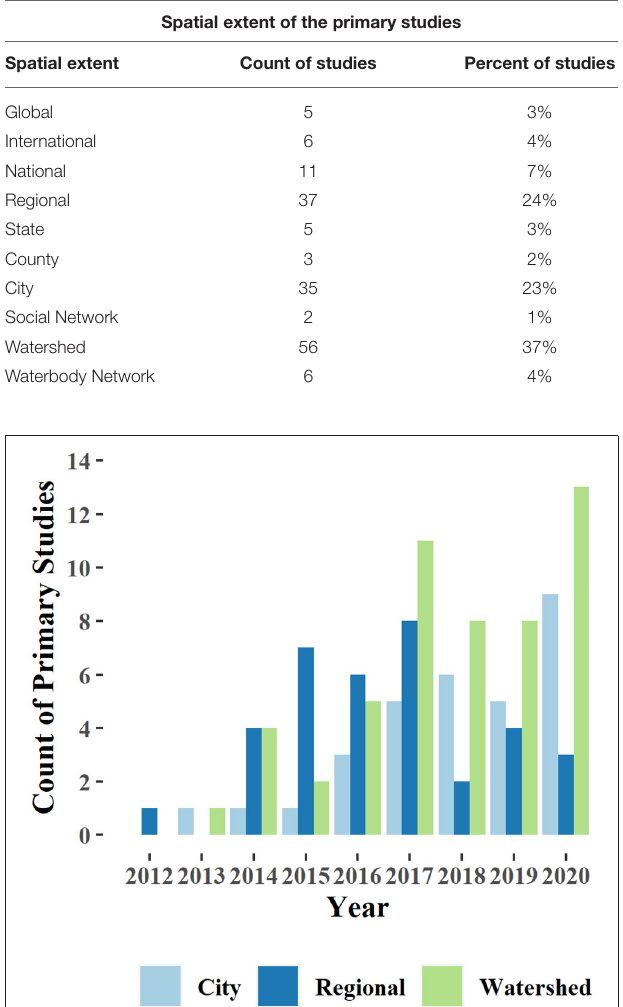
et al., 2018; Oneda and Barros, 2021), wastewater infrastructure (Faust et al., 2017; Tellman et al., 2018; Souza et al., 2021), and human water consumption (Li et al., 2019; Savelli et al.,